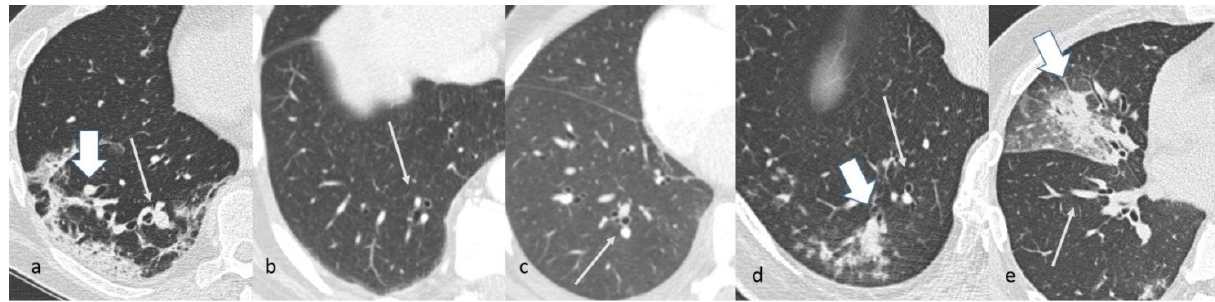
Figure 2. Ratio between the caliber of the segmental branches of the pulmonary arteries and their corresponding bronchial branches, measured on healthy lung parenchyma. COV-P, COVID-19 pneumonia; NL, normal lung; DTE, distal thromboembolism; Bact-P, bacterial pneumonia, Fung-P, fungal pneumonia.